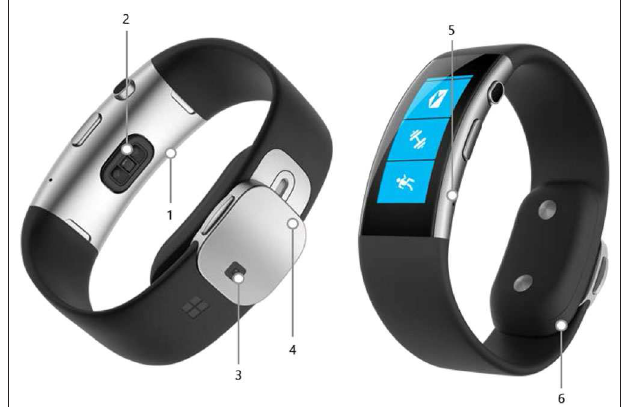
FIGURE 2 | A picture for the Microsoft Band 2. In the Figure 1 , refers to the Barometer, 2 to the Heart rate monitor, 3 to the UV sensor, 4 to the Charging port, 5 to the Microphone, and 6 to the Galvanic skin response (GSR) sensor.